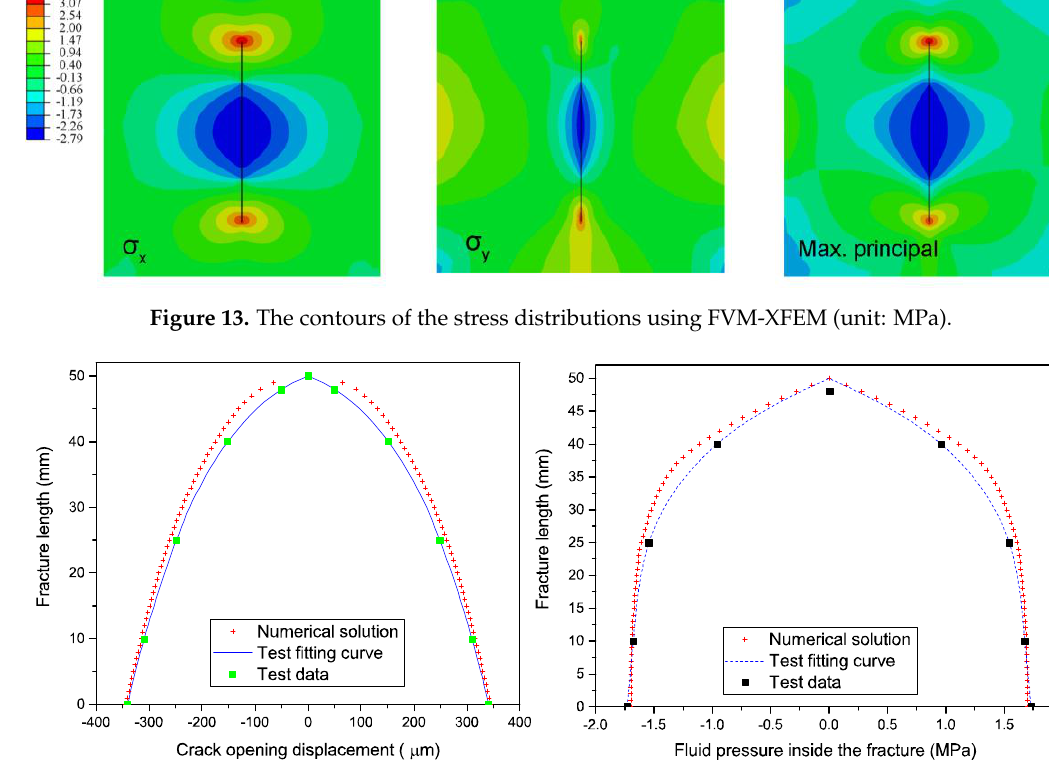
Figure 14. Comparison of the numerical and test results regarding: ( left ) the fracture width and ( right ) the fluid pressure distribution.